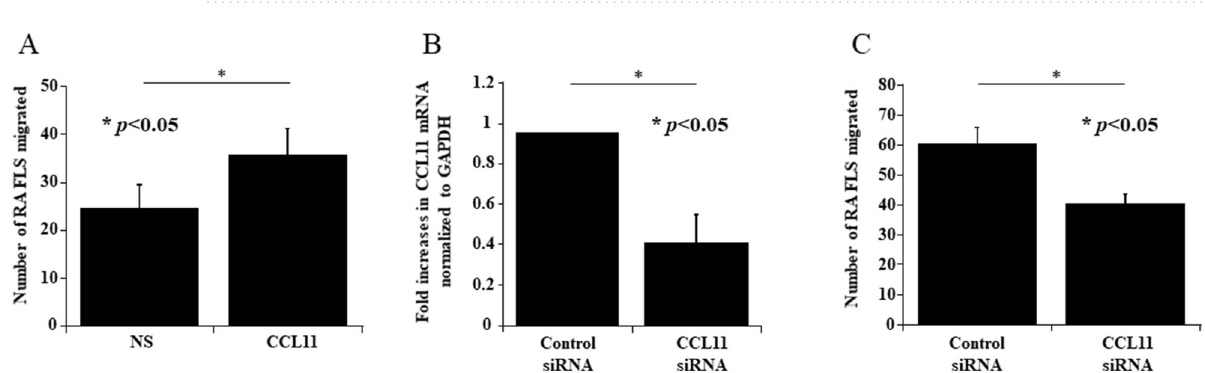
Figure 4. CCL11 stimulation induced CCL11 and CCR3 mRNA. ( A ) RA FLS were stimulated with 200 ng/ mL CCL11 for 12, 24 and 48 h. The expression of CCL11 mRNA at 48 h was induced by CCL11 self-stimulation (n = 5 patients). ( B ) The expression of CCR3 mRNA at 48 h was induced by CCL11 stimulation (n = 5 patients). ( C ) An antagonist of CCR3 (SB328437) at 100 µM reduced TNF-α-induced CCL11 secretion from RA FLS (n = 3 patients). NS no stimulation. The data are expressed as the mean ± SEM. * p < 0.05 was significant.